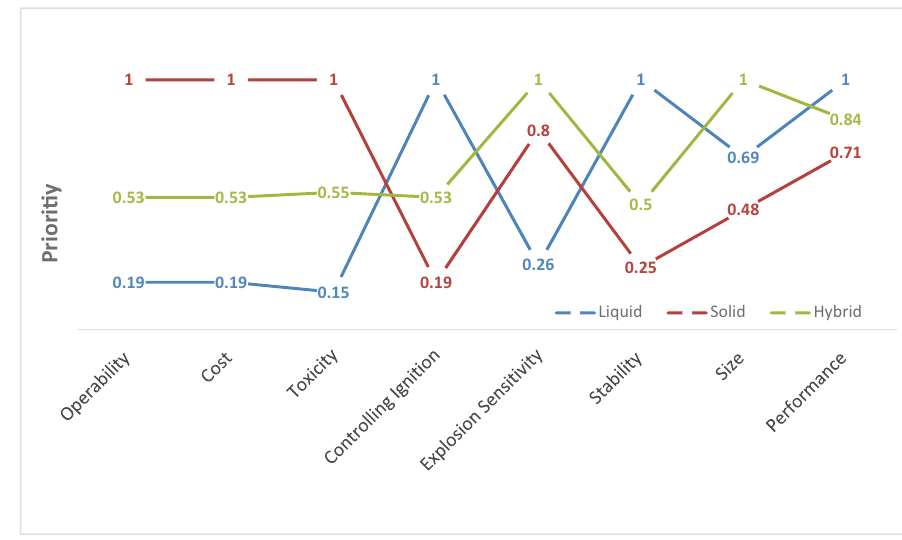
Figure 6: Relative priorities of the alternatives with respect to all criteria in the